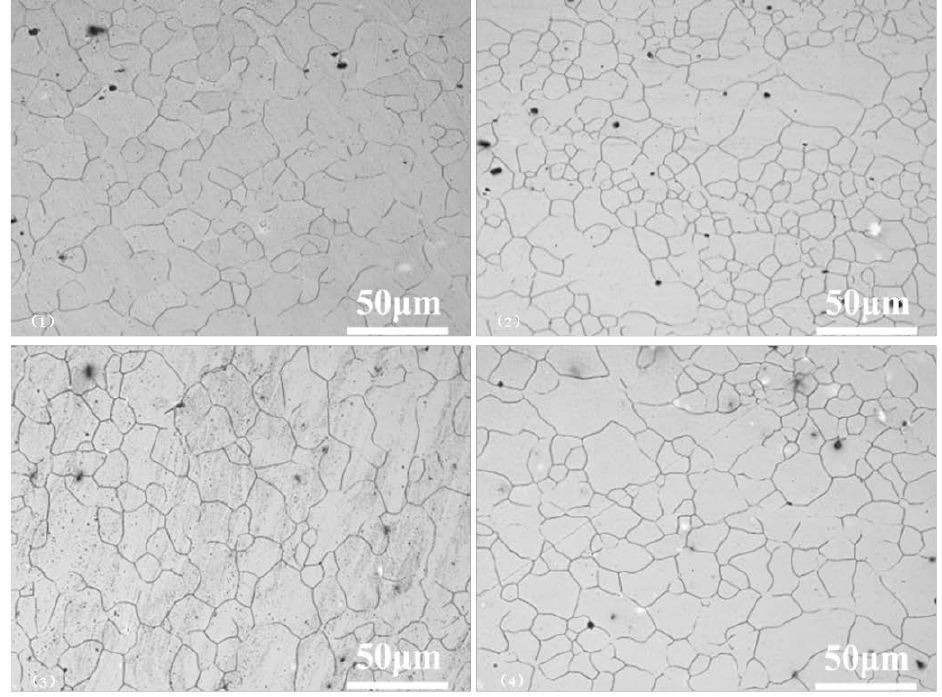
Figure 2. Optical microscopic images of the rolled AZ31 samples in the 0°, 45°, 90°, and vertical (ND) directions.